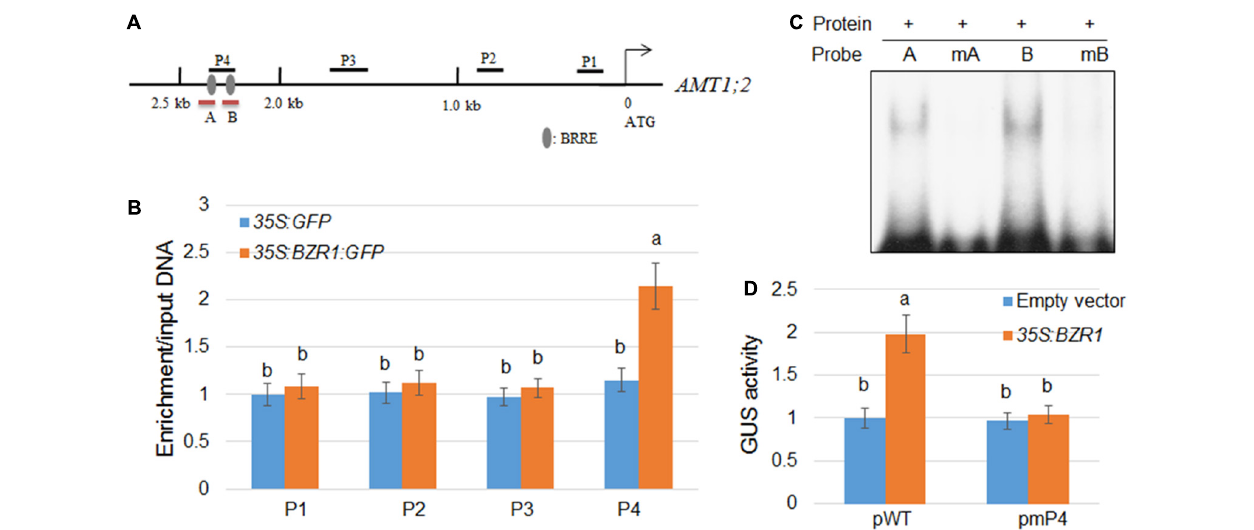
FIGURE 3 | Activation of AMT1;2 by BZR1 via binding to BRRE elements in its promoter region. (A) Schematic diagram showing the position of BRRE in the AMT1;2 promoter and probes used for ChIP detection. The gray oval represents BRRE, the letters P (1, 2, 3, 4) indicate the positions of the probe. Red lines under the BRRE elements indicate the probe used in the EMSA analysis. (B) An anti-GFP antibody was used to amplify immunoprecipitated DNA in the 2.5 kb AMT1;2 promoter (P1–P4) for CHIP detection. The qPCR method was used to determine the relative ratios of immunoprecipitated DNA to input DNA. Input DNA was used for data normalization. Data represent means ± SE ( n = 3). Transgenic plants expressing GFP and BZR1-GFP under control of 35S promoter were used. Different letters represent statistically significant differences ( P < 0.05). (C) The affinity of BZR1 to each BRRE elements (A and B) located in P4 region was evaluated by EMSA. The BRRE motif sequence (CGTG T / C G) was replaced with the sequence TTTTTT in the mA and mB probes, and the mutant BRRE probes (mA and mB) were used as the negative controls. (D) 35S:BZR1 and each GUS-expressing vector were subjected to transient co-expression experiments under the control of the natural and BRRE-mutated AMT1;2 promoters. The activation of the native promoter (pWT) and BRRE element mutated promoter (pmP4) was measured in protoplasts that were co-transformed with 35S:BZR1 . The GUS expression data was normalized by the luciferase gene driven by the 35S promoter. Error bars are ± SE of the means ( n = 3). The experiments were repeated at least three times. Different letters represent statistically significant differences ( P < 0.05).